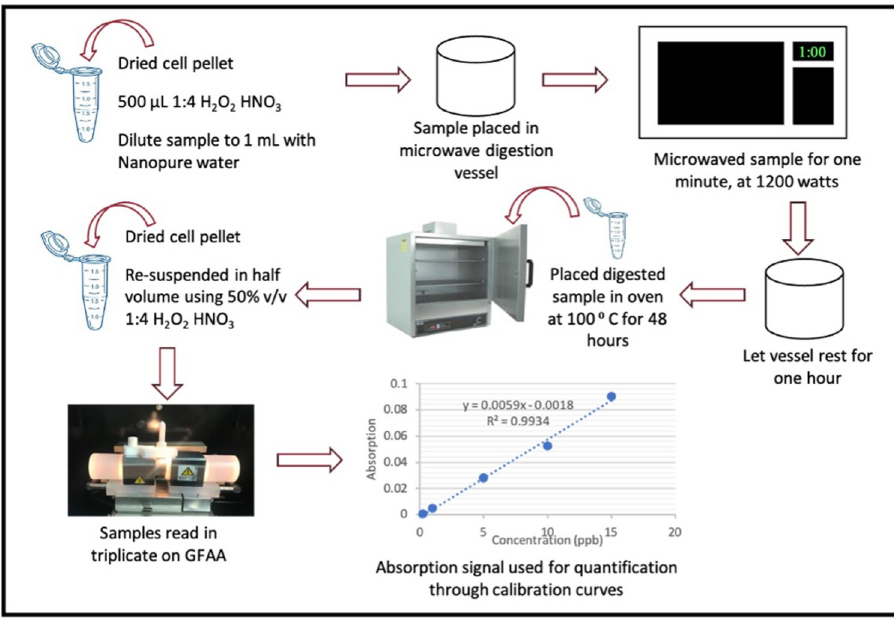
Fig 4. Optimized microwave assisted acid digestion for determination of lead in E . coli